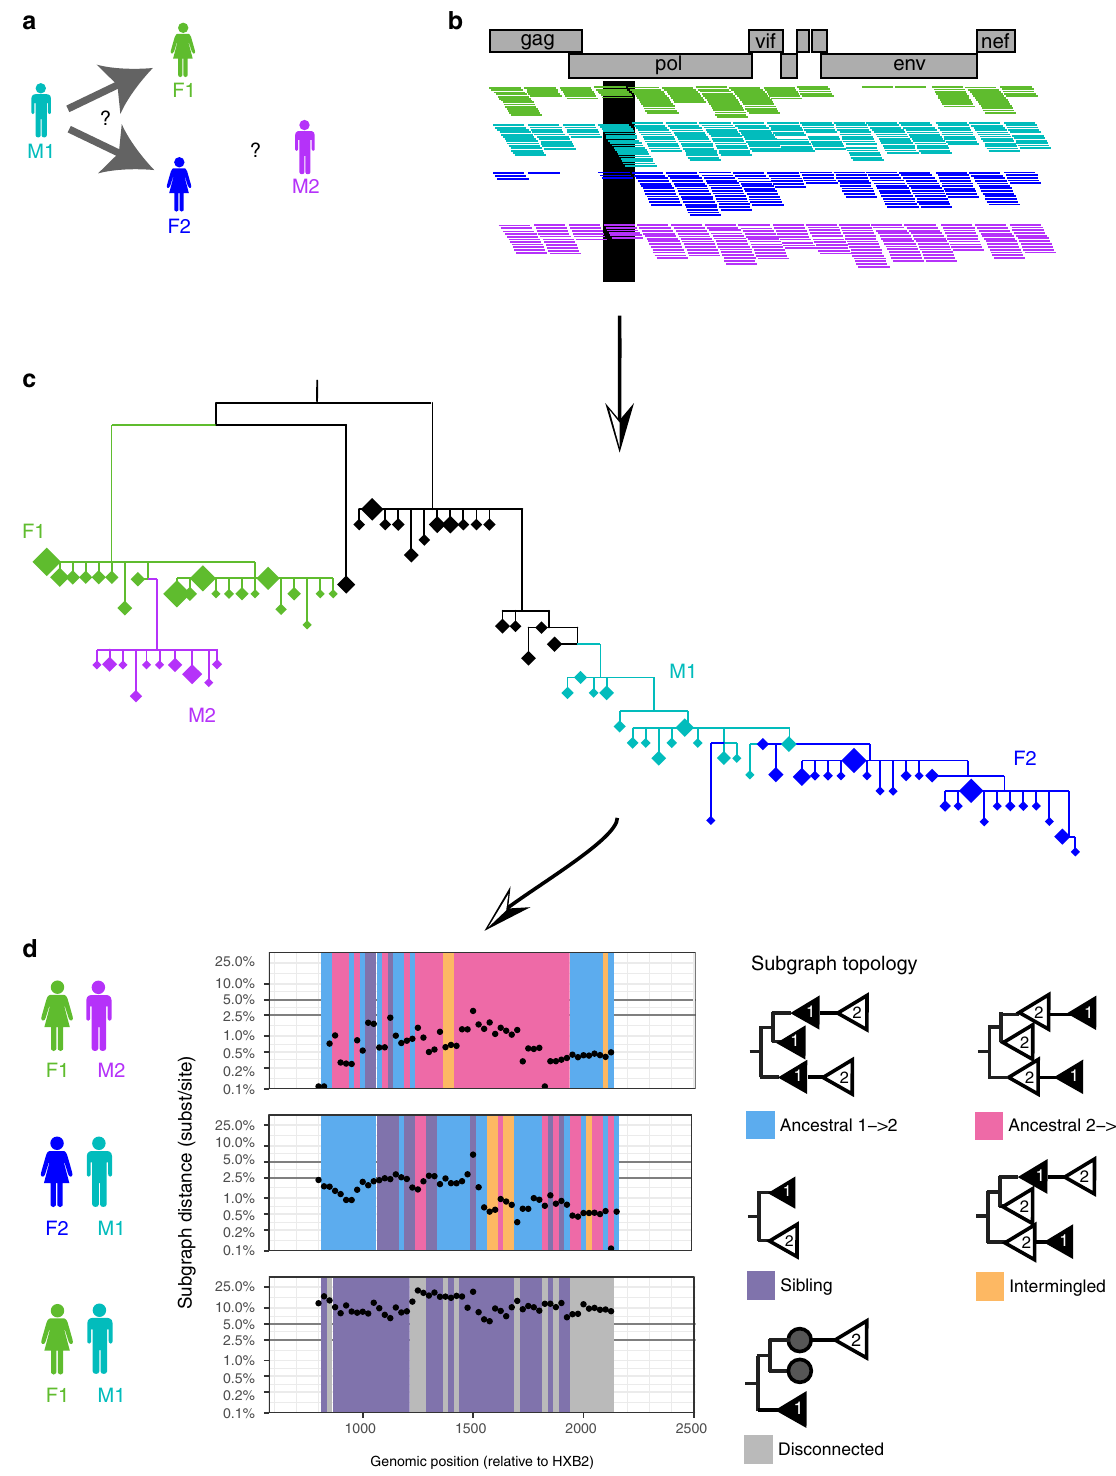
Scaling deep-sequence phylogenetics to large data sets . We fi rst investigated the types of deep-sequence phylogenetic patterns that arise in known epidemiologic relationships. Our population- based sample comprised 331 concordant HIV-1-positive couples who self-identi fi ed as sexual partners. Based on previous partner analyses 16,17 , we expected that virus was transmitted in approximately 70% of couples, and that the remaining couples were separately infected by other individuals. Figure 1d illustrates